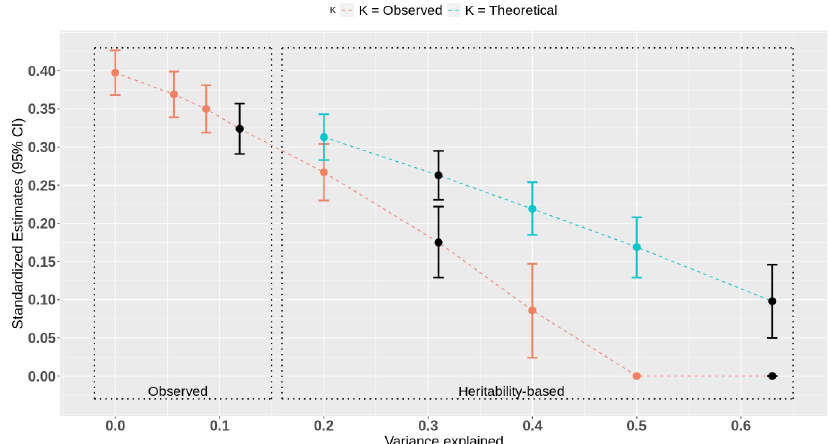
Fig 1. Gsens analysis of the effect of maternal educational attainment on child educational achievement. Estimated standardized effect of maternal education on child educational achievement (Y axis) after accounting for genetic confounding using observed polygenic scores and heritability-based scenarios explaining an increasing percentage of variance (X axis). Point estimates and confidence intervals in black represent main estimates of interest, after accounting for (from left to right): 1: the best-fitting polygenic score; 2: SNP-heritability of educational achievement as assessed by GCSE scores in TEDS; 3: twin-heritability of educational achievement. A lower bound of 0 was imposed on the estimate, which is reached for the twin estimate of heritability (63%). The line “ k = Observed” corresponds to heritability-based scenarios using values of model parameter k derived from observed polygenic scores (see Methods). “ k = theoretical” corresponds to the value of k when the same trait is in parents and children and the heritability is the same in parents and children. In this case k = 0.5 (see Methods).